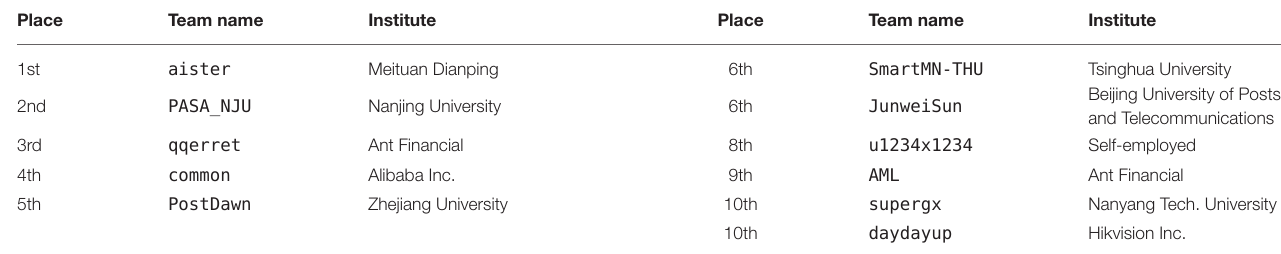
Two teams tie in the 6th and 10th place. We list them both.